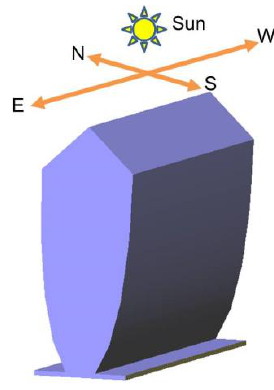
Figure 11. The alignment of the system along the NS and EW directions.